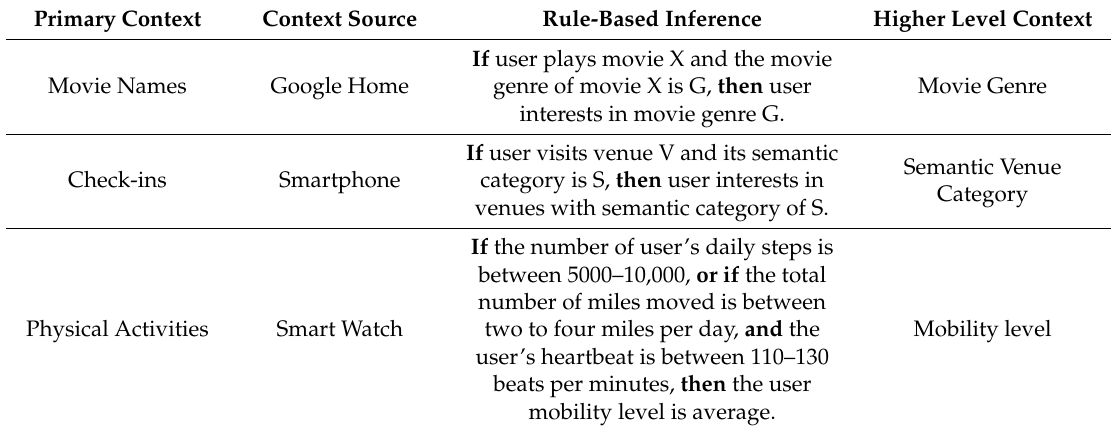
Table 3. Examples of applied rules in the context reasoning